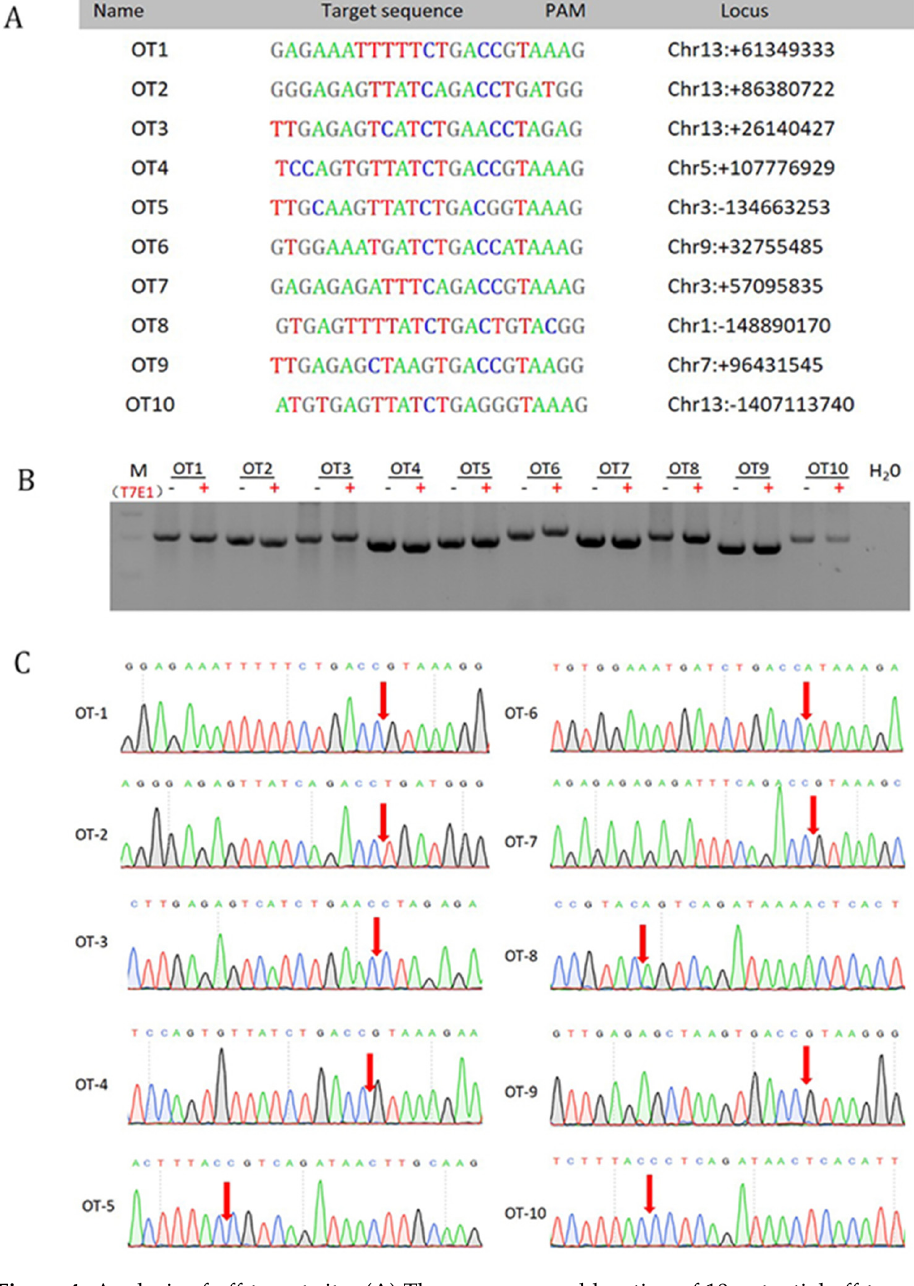
Figure 4. Analysis of off-target site. ( A ) The sequence and location of 10 potential off-target (OT) sites for sgRNA91/Cas9. ( B ) Cleavage analysis of 10 potential OT sites by T7E1. M: DNA 2000. ( C ) Sanger sequencing analysis of the PCR amplification products for 10 potential OT sites. The potential cleavage site of sgRNA91 has been marked with red arrow.